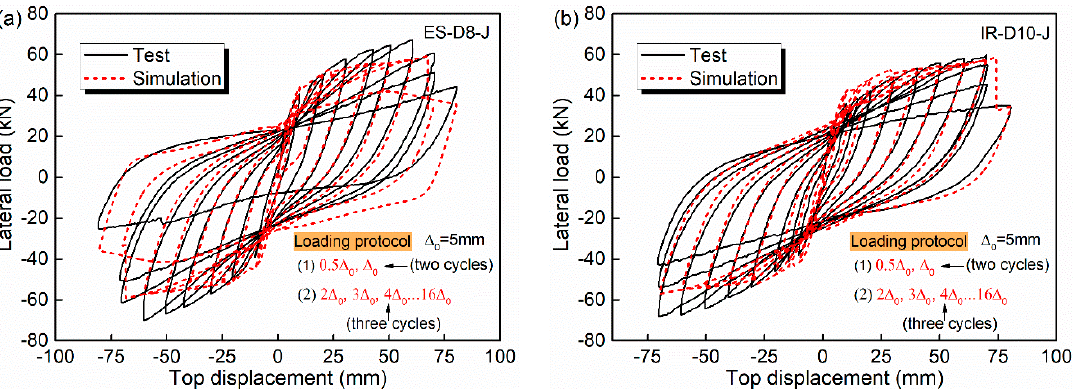
Figure 7. Simulation and test results of lateral load-top displacement: ( a ) Specimen ES-D8-J; ( b ) Specimen IR-D10-J.